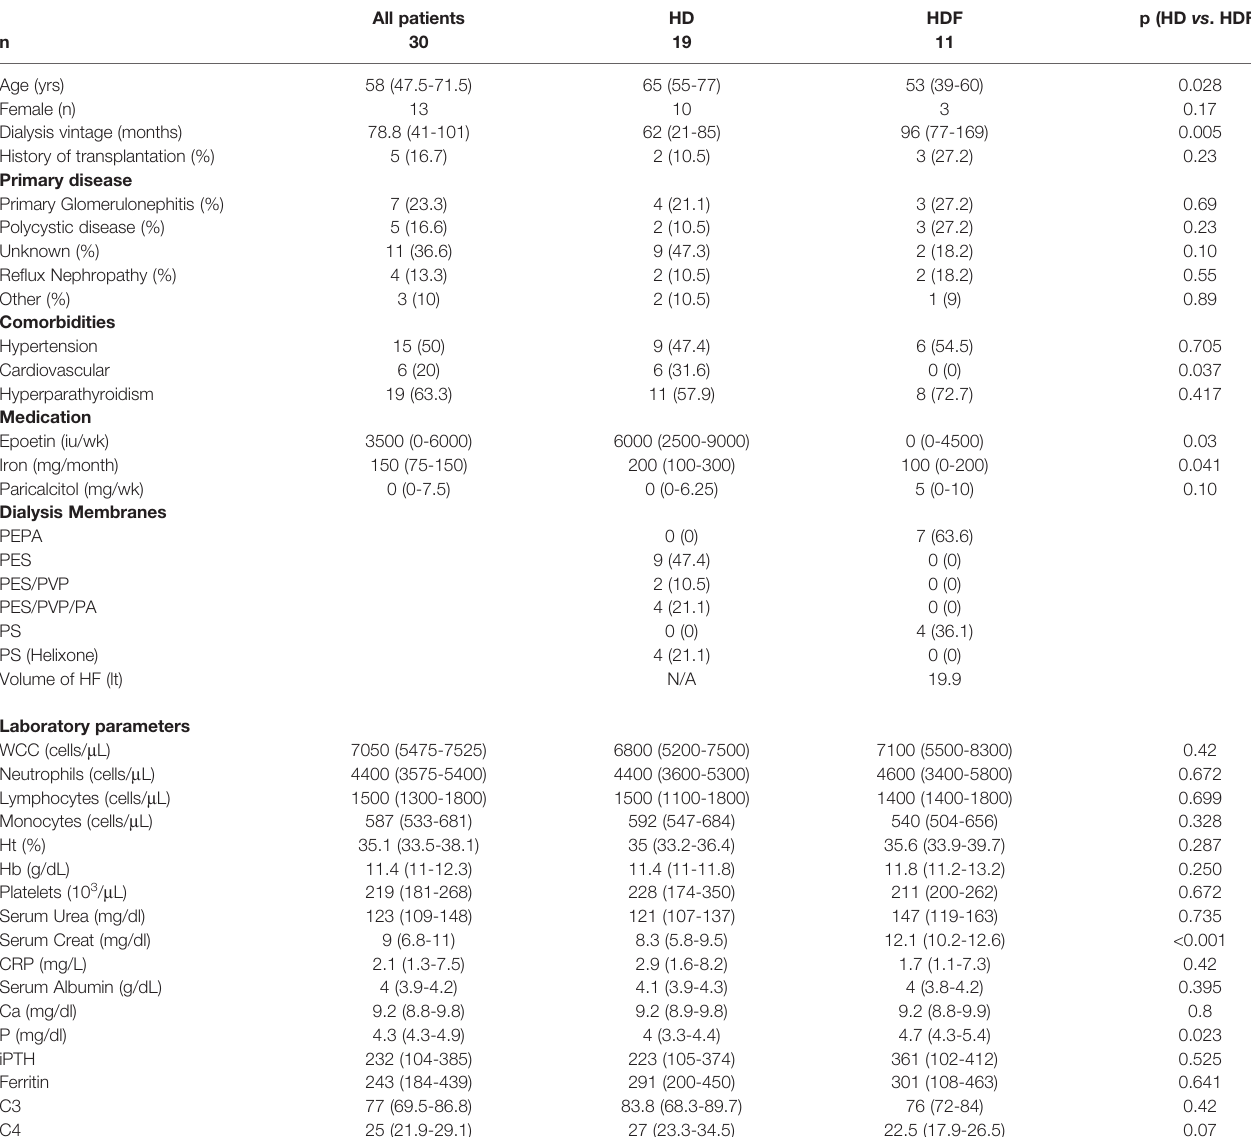
TABLE 2 | Patients ’ characteristics.